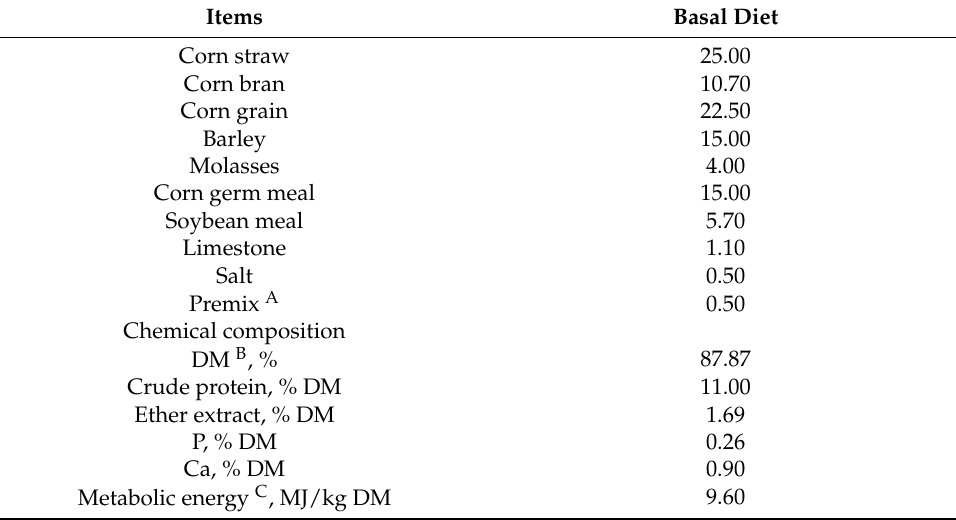
Table 1. Ingredients and chemical compositions of the diet used in the